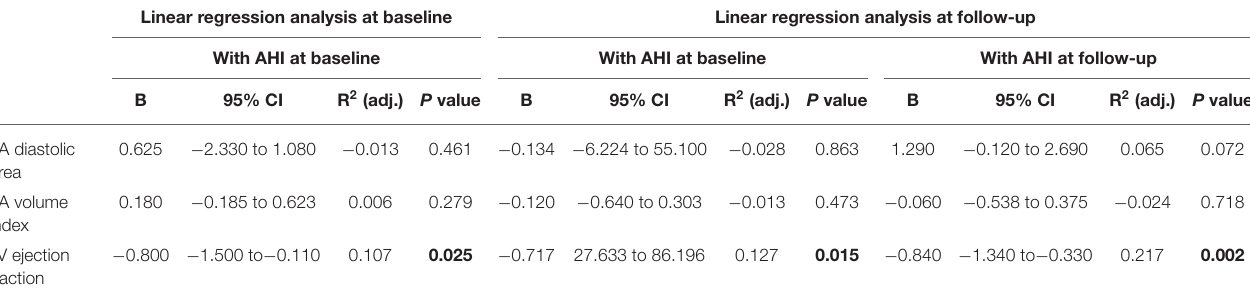
TABLE 2 | Linear regression of AHI with volumetric LA parameters and volumetric ventricular parameters. Linear regression analysis at baseline Linear regression analysis at follow-up With AHI at baseline With AHI at baseline With AHI at follow-up